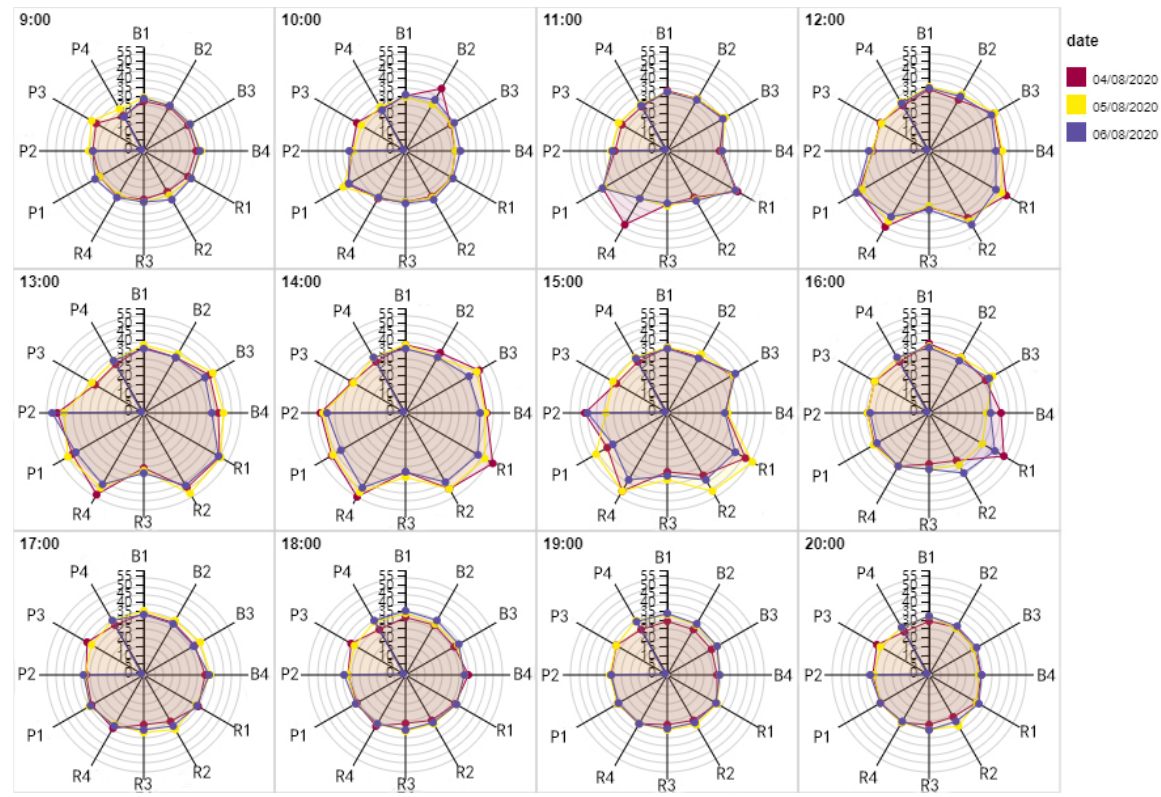
Figure 9. The change of PET at each measurement point during the actual measurement period.